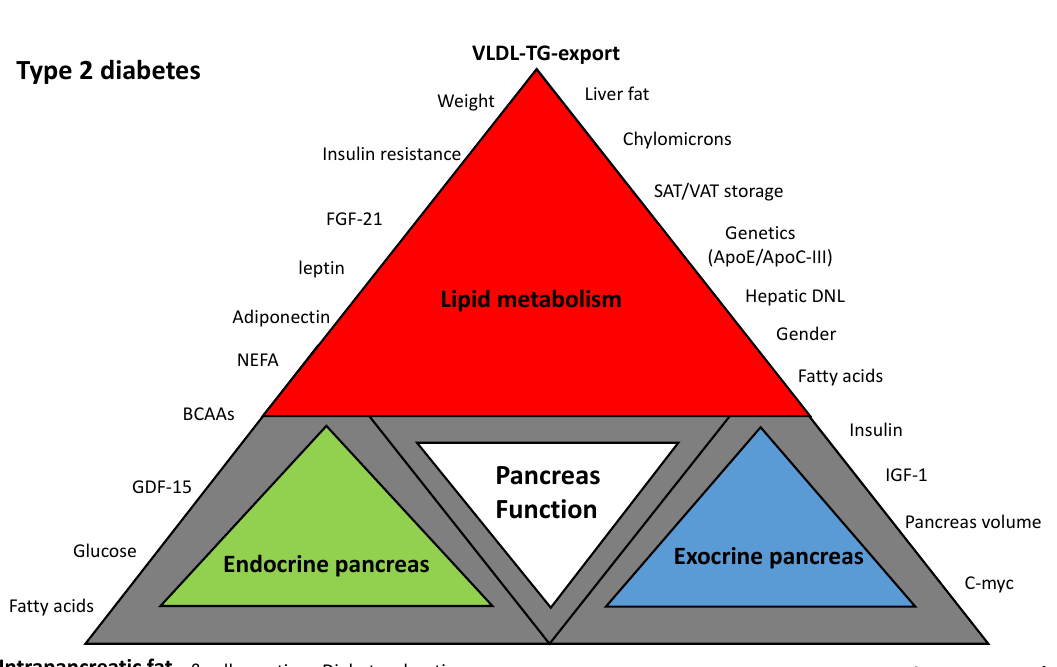
Figure 1. Schematic hypothetical diagram of the interplay between hepatic very low density lipoprotein triglyceride (VLDL-TG) export and intrapancreatic fat in type 2 diabetes. Pancreas function is accomplished through the synergy between endocrine and exocrine compartments. Abnormalities in lipid metabolism are the drivers of metabolic events that affect overall pancreas structure and function. The extent of each colored triangle represents the degree of function in that parameter (gray color means loss of function). Lipid-driven changes that cause dysfunction of β-cells in type 2 diabetes mellitus (T2DM) and the loss of the acinar cells mass are likely to be related to hepatic VLDL-TG export and increase in intrapancreatic fat. β-cell: Beta cell; VLDL-TG: very low density lipoprotein triglyceride; FGF-21: fibroblast growth factor 21; NEFA: non-esterified fatty acids; BCAAs: branched-chain amino acids; GDF-15: growth differentiation factor-15; GLP-1: glucagon-like peptide- 1; C-myc: cellular myelocytomatosis oncogene; IFG-1: insulin-like growth factor- 1 ; DNL: de novo lipogenesis; ApoE: apolipoprotein E, ApoC-III: apolipoprotein C-III ; SAT: subcutaneous adipose tissue; VAT: visceral adipose tissue.